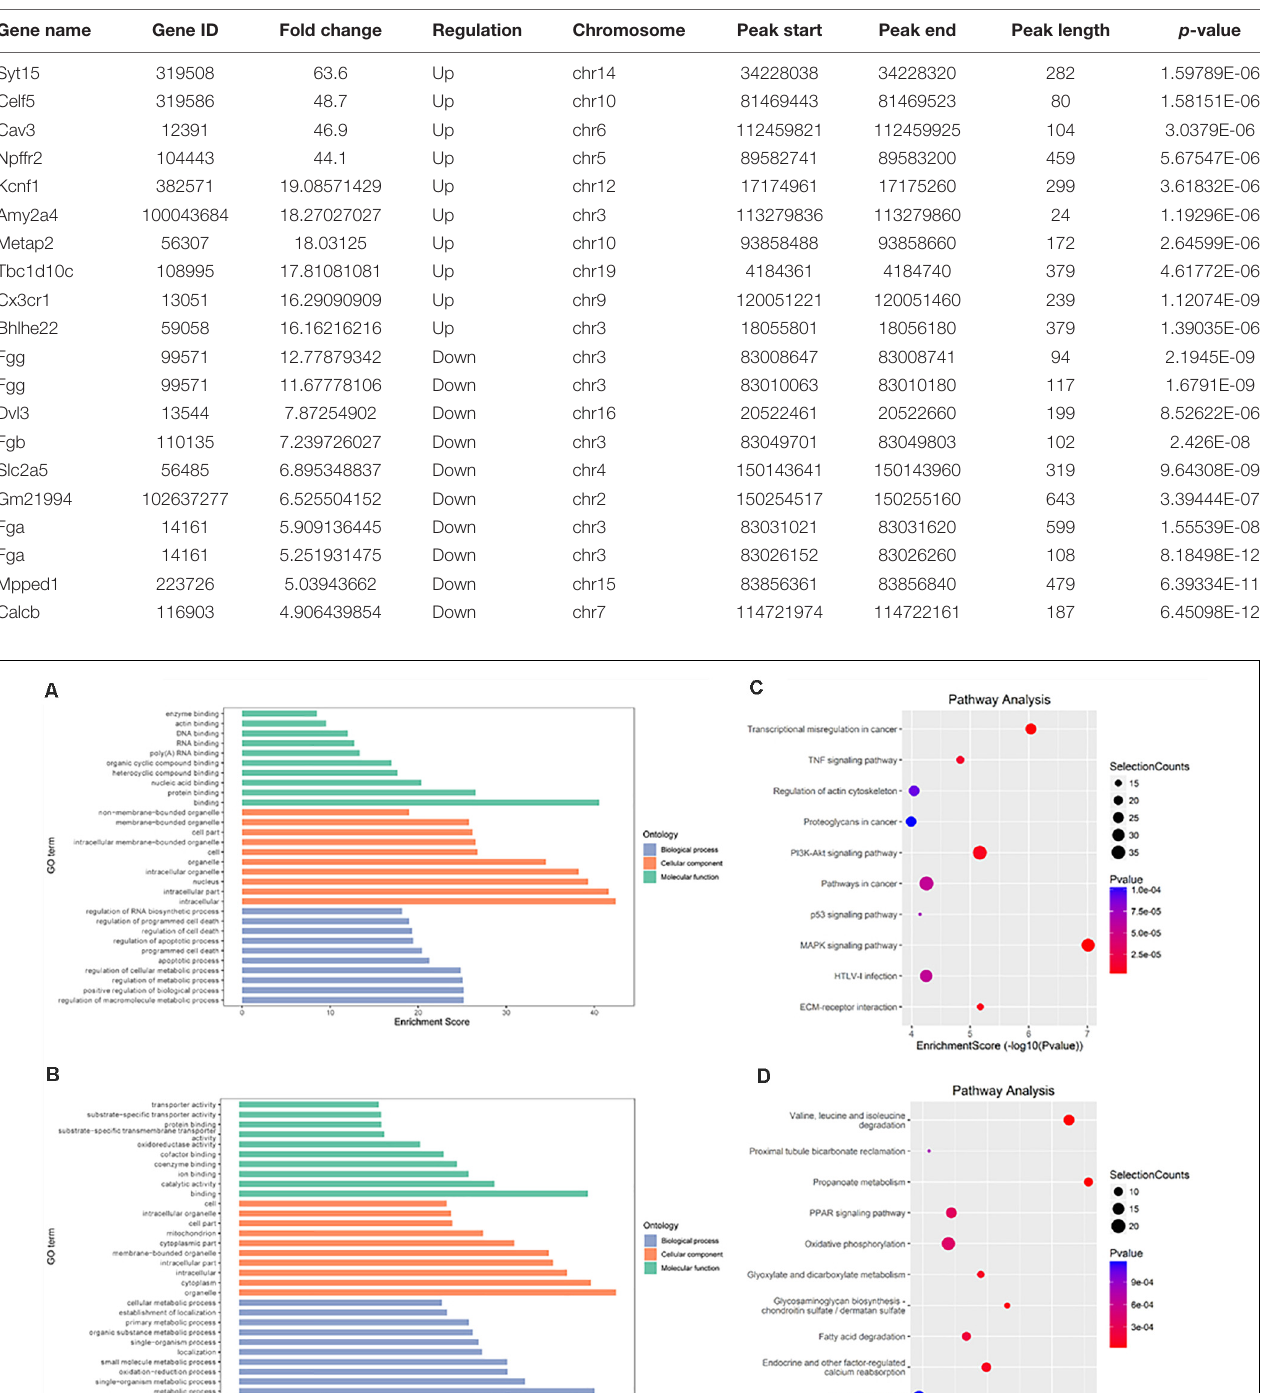
Frontiers in Genetics |